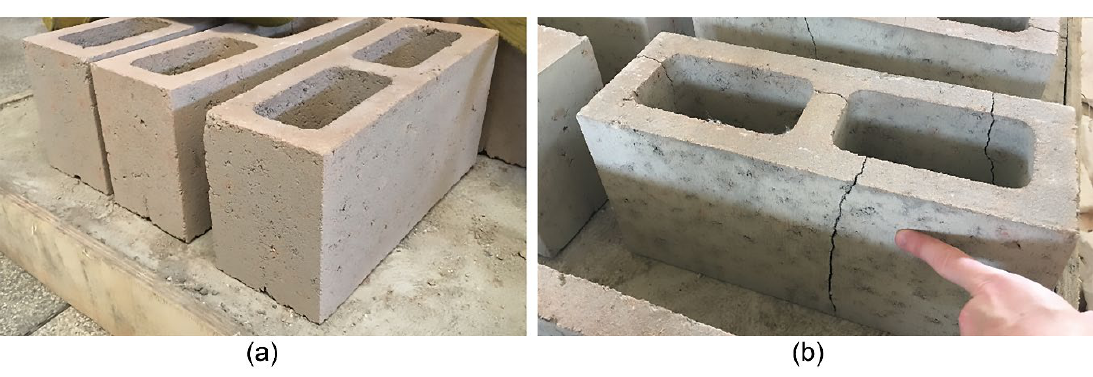
Figure 9. Blocks with nominal strength of (a) 4 MPa and (b) 10 MPa after